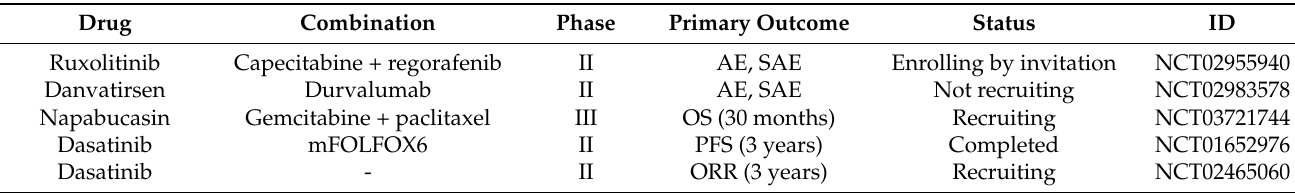
Table 6. Therapeutics targeting JAK-STAT/Src pathway components and their activity in ongoing clinical trials for the treatment of pancreatic cancer.